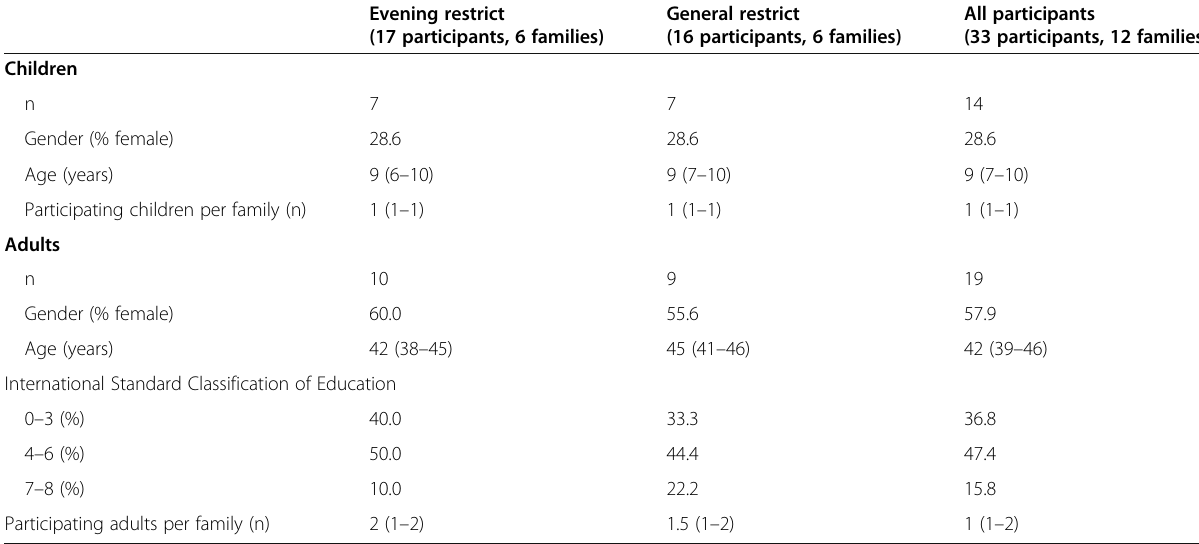
Table 1 Baseline characteristics